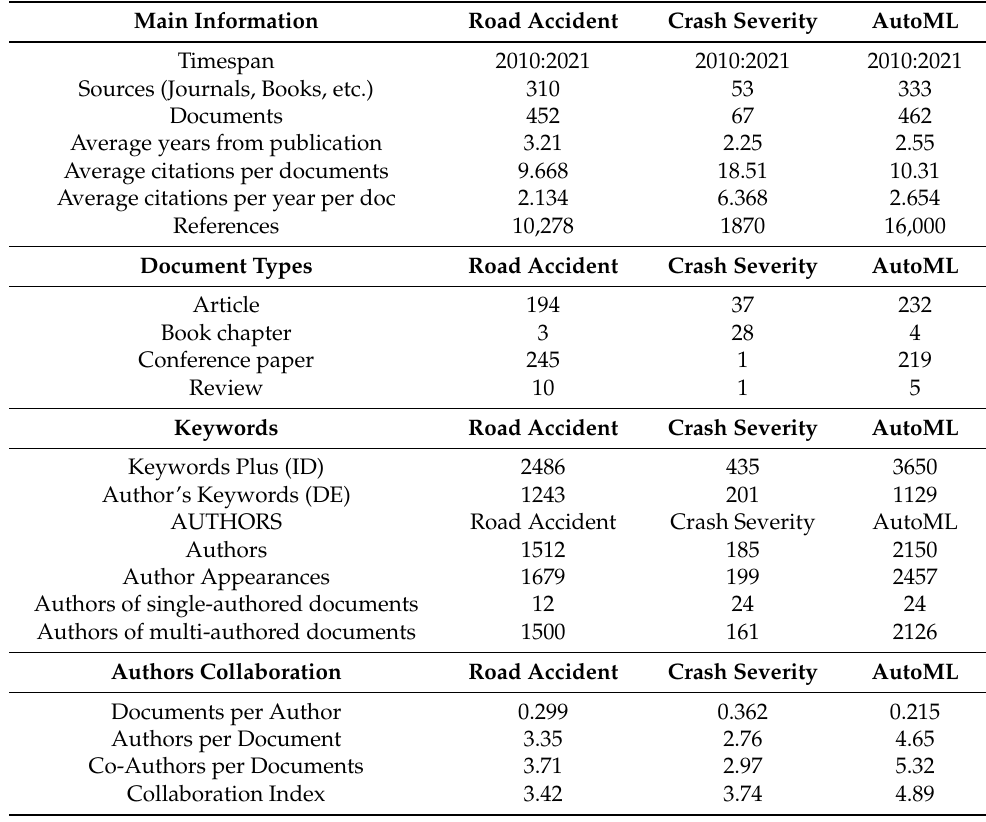
Figure 2. Criteria considered for the inclusion and exclusion of literature related to CSP, ML, and AutoML. Table 1. Bibliographic information of the studies reviewed for Road Accident, Crash Severity, and